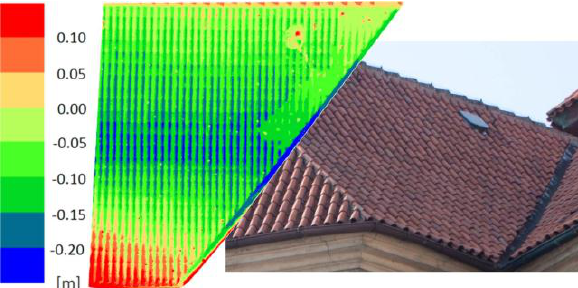
Figure 5. Left: Distance differences between modelled plane of roof and scanning points. Right: part of modelled roof.